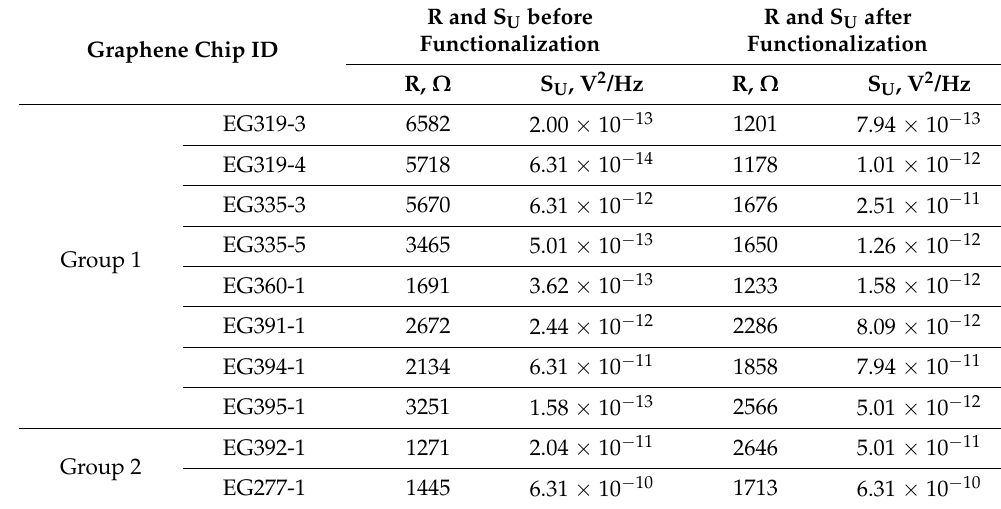
Table 1. Typical parameters of graphene chips before and after functionalization. Graphene Chip ID